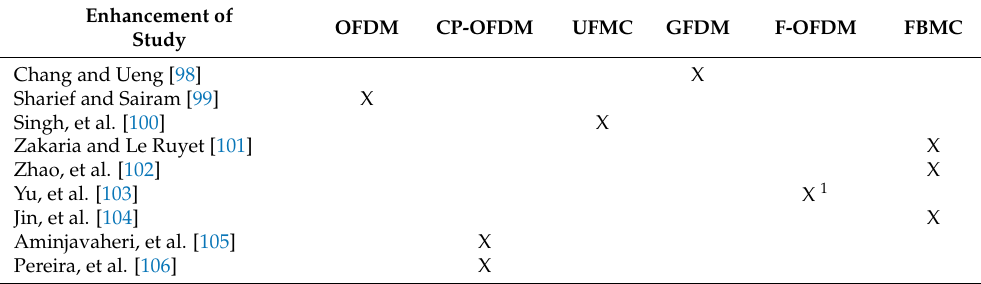
Table 5. MIMO-OFDM variants enhanced